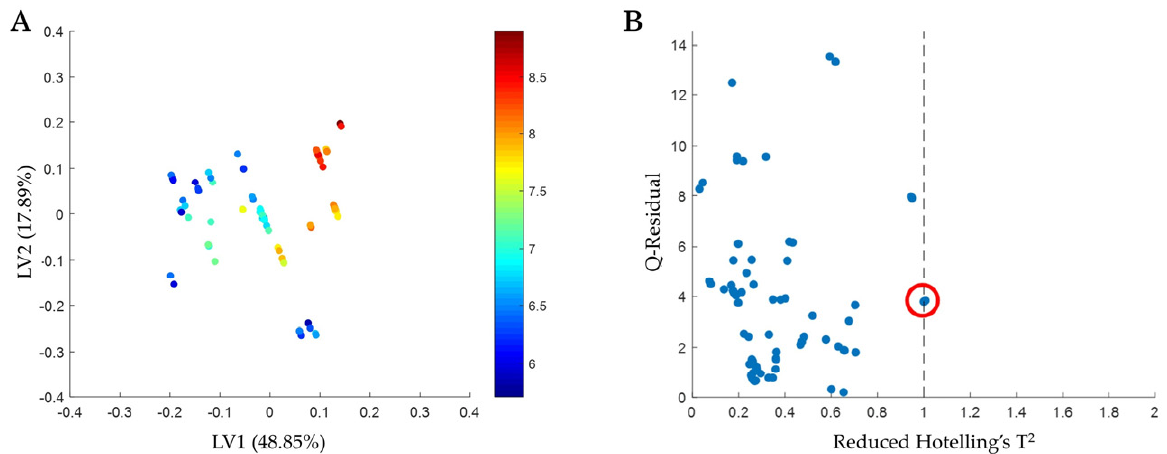
Figure 4. ( A ) The plot of the scores on LV1 versus the scores on LV2 for the mAb- δ PLSR model. The color represents the complex afucosylation level. ( B ) The Q-residual vs. Reduced Hotelling’s T 2 diagnostic plots for mAb- δ PLSR model. The dashed line represents the significance threshold for the reduced Hotelling’s T 2 , with unusual samples circled in red.